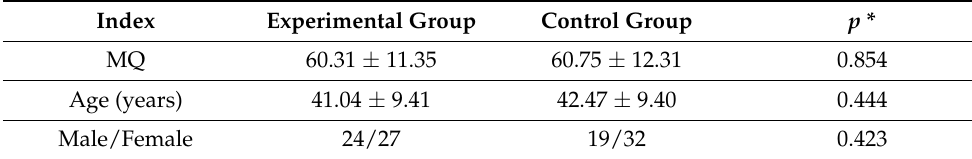
Table 1. Baseline distribution comparison of two groups before clinical trial.